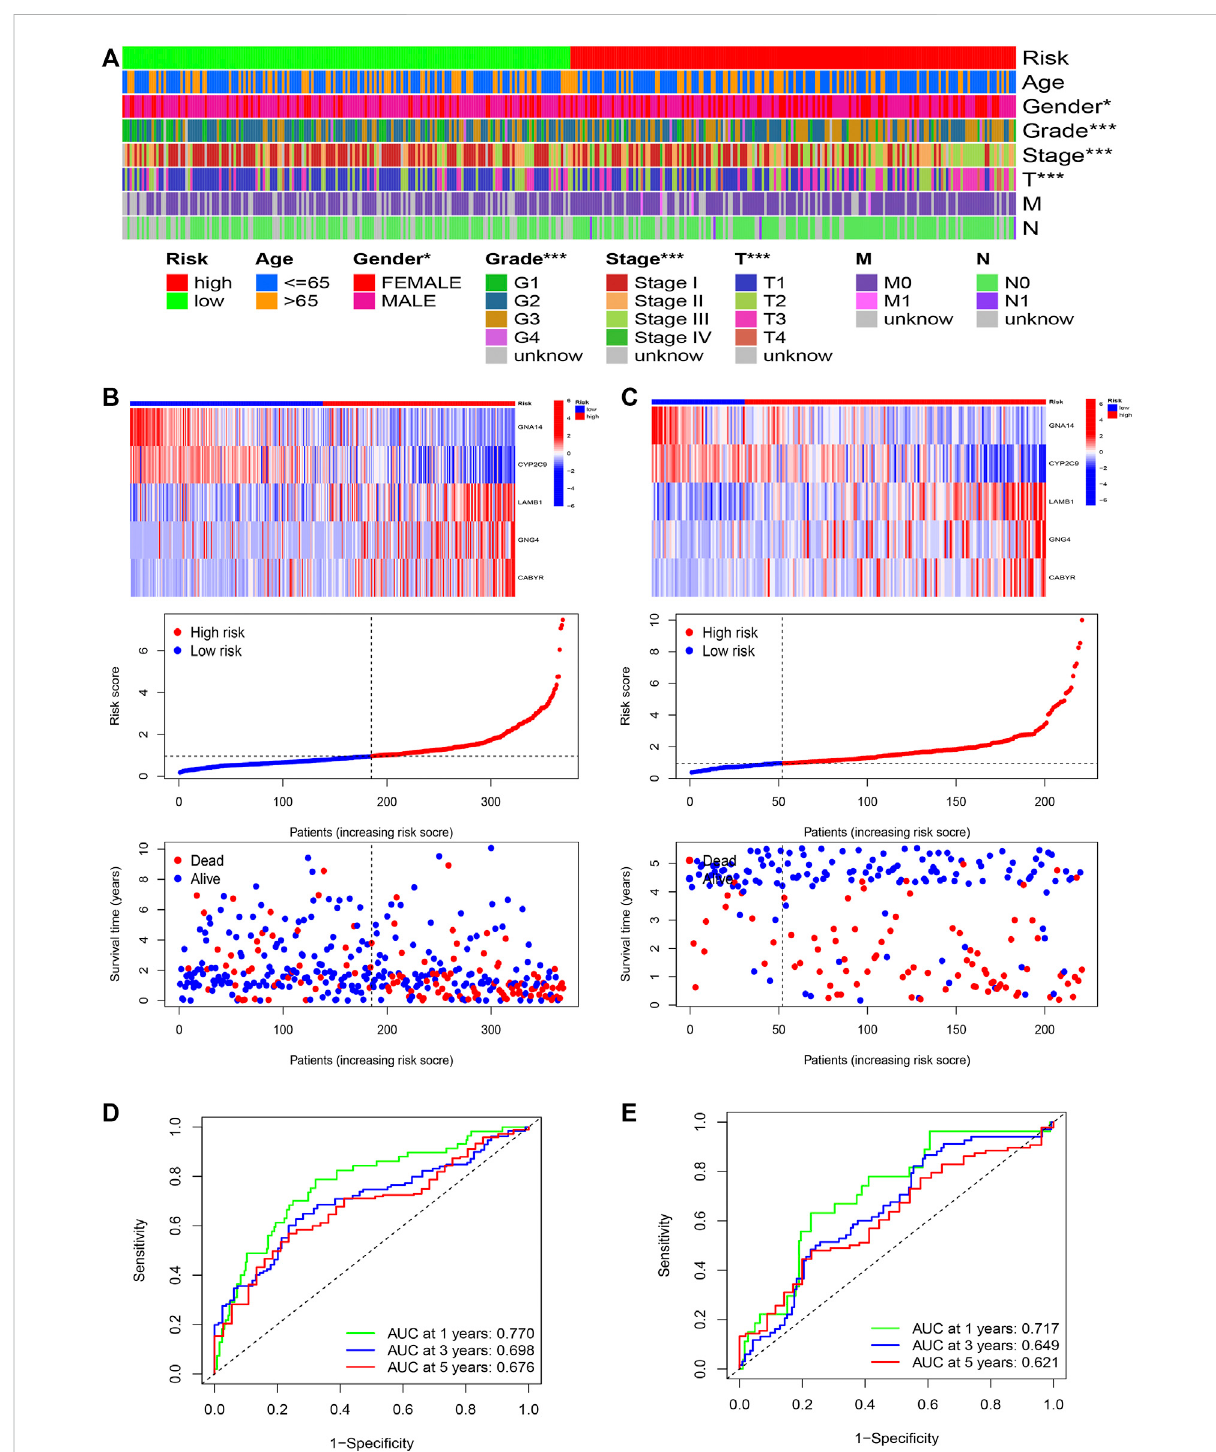
FIGURE 7 Theriskmodelof fi ve-genesignature. (A) Thecorrelatedheatmapoftheriskscoreandclinicalfeatures.(* p < 0.05;** p < 0.01;*** p < 0.001). (B) The fi ve-gene mRNA expression, risk score distribution, and the related survival data in the TCGA cohort. (C) The fi ve-gene mRNA expression, risk scoredistribution,andtherelatedsurvivaldataintheGSE14520cohort. (D) ROCcurvesfor1-,3-,and5-yearsoverallsurvivalpredictionsintheTCGA cohort. (E) ROC curves for 1-, 3-, and 5-years overall survival predictions in the GSE14520